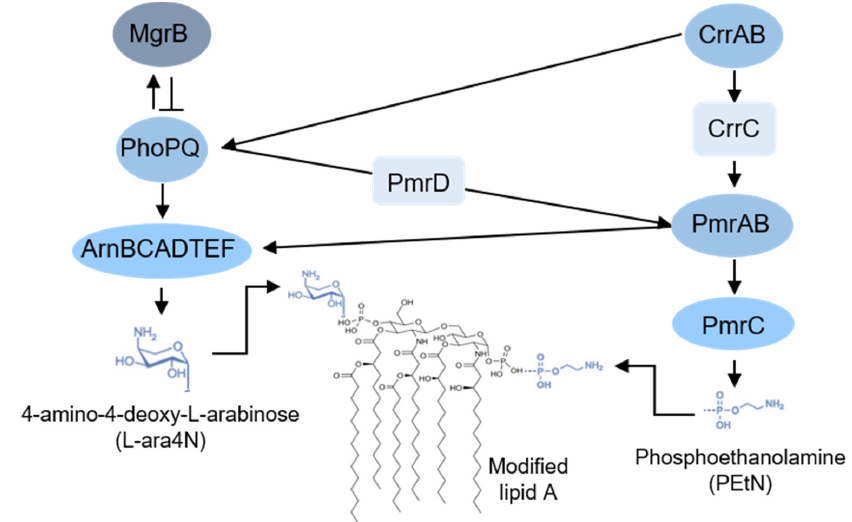
Figure 3. Regulatory network of Lipid A modification in Klebsiella pneumoniae.